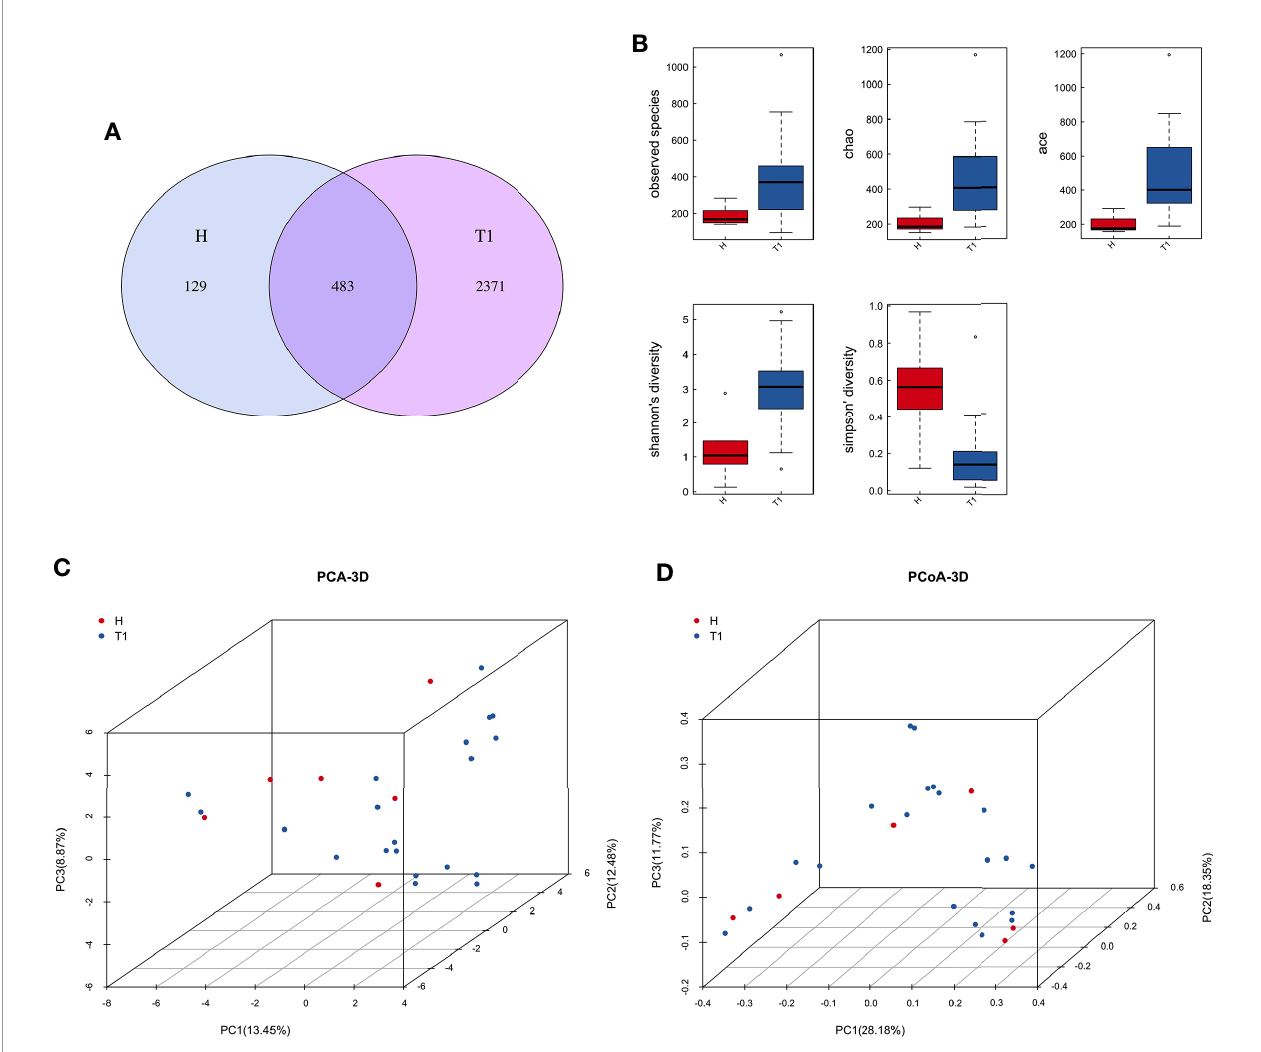
FIGURE 1 | (A) Venn diagram for the integration between healthy controls and cervix cancer patients OTUs. (B) Principal component analysis (PCA) of vaginal microbiome of 20 patients and 6 healthy controls. (C) The comparison between patients and healthy controls by alpha diversity analysis. (D) The comparison between patients and healthy controls by beta diversity analysis. H, Healthy controls; T1, the fi rst time point sample of patients.